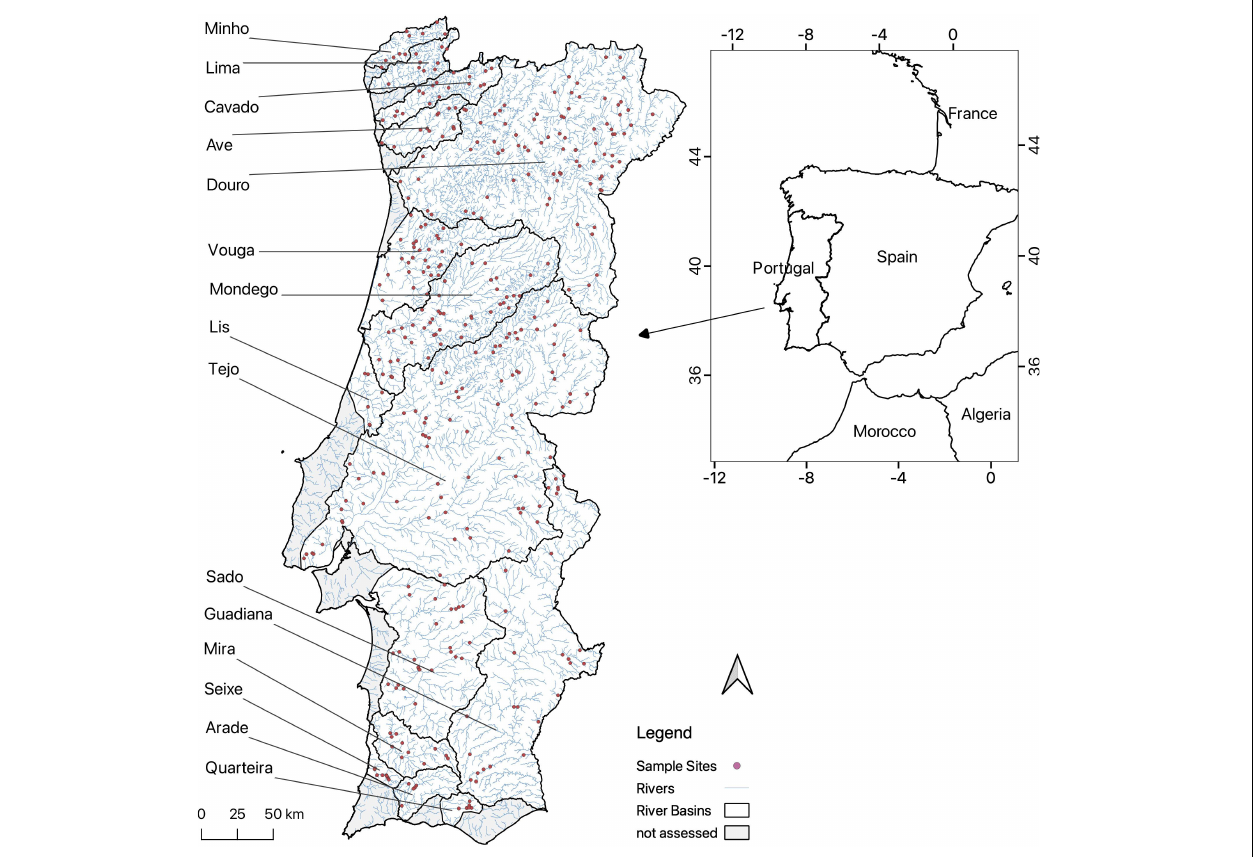
FIGURE 1 | Map of continental Portugal with the location of the 382 analyzed vegetation plots (red dots) and the 15 river basins that were considered; the black lines delimit the river basins. This figure was created using QGIS Version 3.14 with the coordinate reference system ETRS 89/Portugal TM06 (QGIS Development Team,